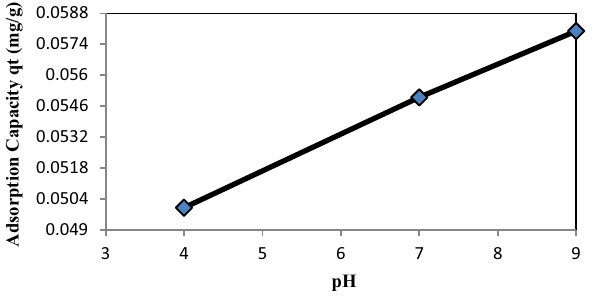
Fig. 4 Efficiency of arsenic removal at varying concentration, 120 rpm, pH = 7.0 and 30